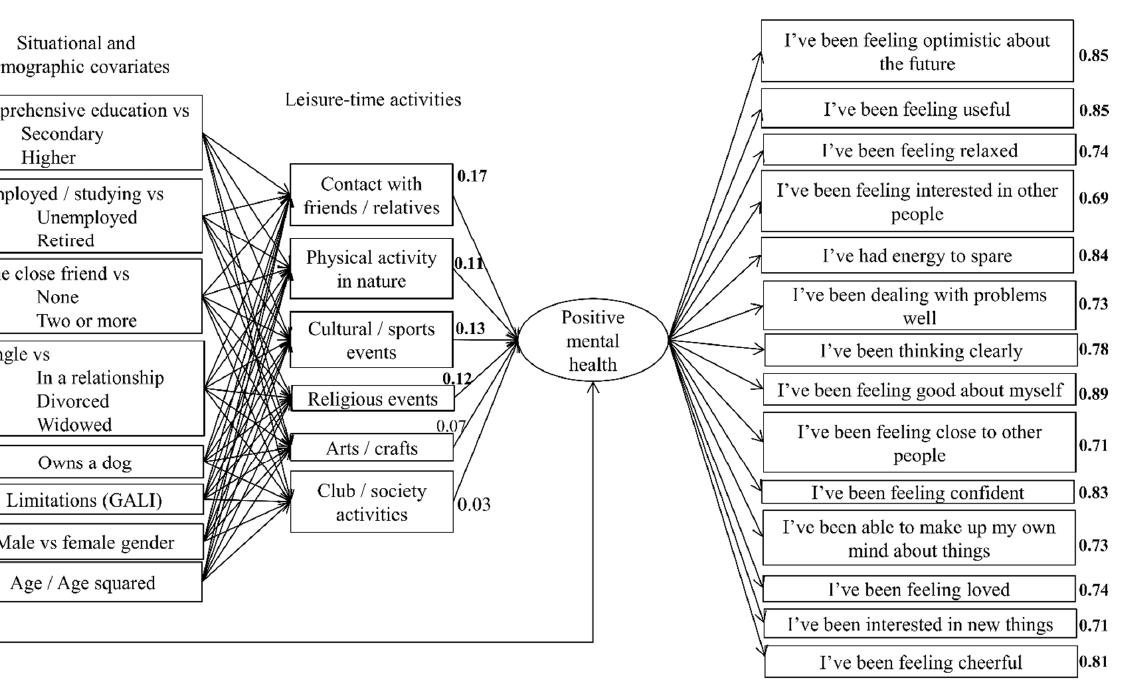
Figure 2. Illustration of the main reported structural equation model ( n = 801) where positive mental health is specified as a latent factor whose loadings (reflecting correlation between the factor and the items) are shown at the right side of each item. The residual correlations between the leisure-time activities and the path estimates from each situational and demographic covariate to each leisure-time activity and positive mental health were estimated but they are not shown for clarity (provided in Table 2, Figure 3, and Appendix A Table A2). In bold: the 95% CI of the standardised estimate does not overlap with